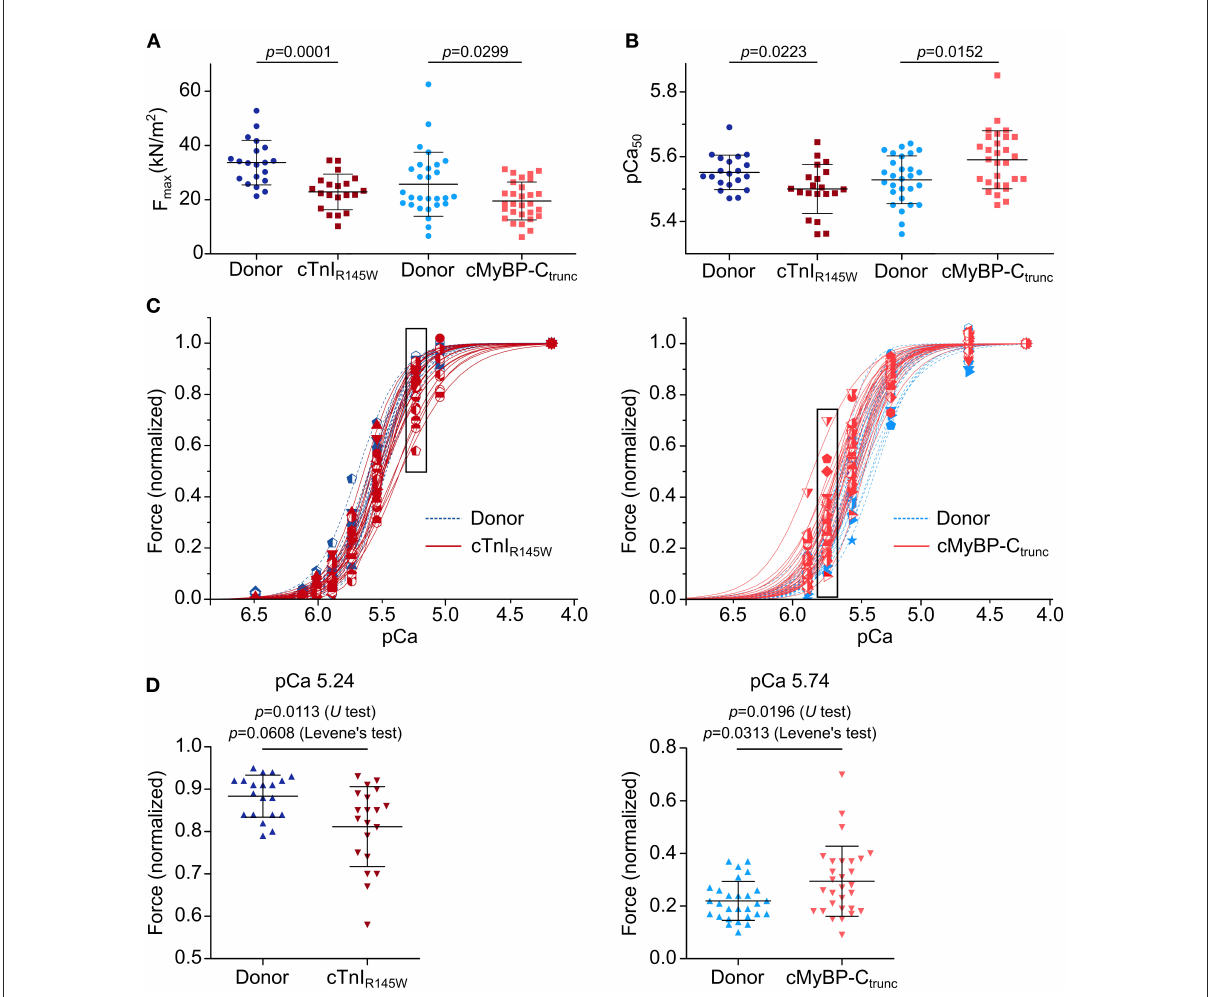
FIGURE4 Contractile imbalance among cardiomyocytes from cMyBP-C trunc and cTnI R145W. Individual cardiomyocytes from cTnI R145W patient, cMyBP-C trunc (c.927-2G > A) patient and respective donors were permeabilized and subjected to different calcium concentrations to measure calcium-dependent force generation. (A) Maximum force generation (pCa 4.18) and (B) pCa 50 values of individual cTnI R145W cardiomyocytes (n = 20), of cMyBP-C trunc (n = 28) and of the corresponding donor cardiomyocytes (n = 20 and n = 29). pCa 50 was derived from Hill-fits of normalized force-pCa relations. p-values of U test are indicated in the figure. (C) Force-pCa relations were plotted for individual cTnI R145W cardiomyocytes, for cMyBP-C trunc cardiomyocytes and the respective donor cardiomyocytes. Patient cardiomyocytes, red symbols and solid lines; donor cardiomyocytes, blue symbols and dashed lines. Force values in black boxes are plotted in (D). (D) Normalized forces of individual cardiomyocytes are shown for cTnI R145W vs. the respective donor at pCa 5.24, and for cMyBP-C trunc versus the respective donor at pCa 5.74. Each symbol represents an individual cardiomyocyte. Mean ± SD and p-values for U-test and Levene’s test are indicated in the figure.